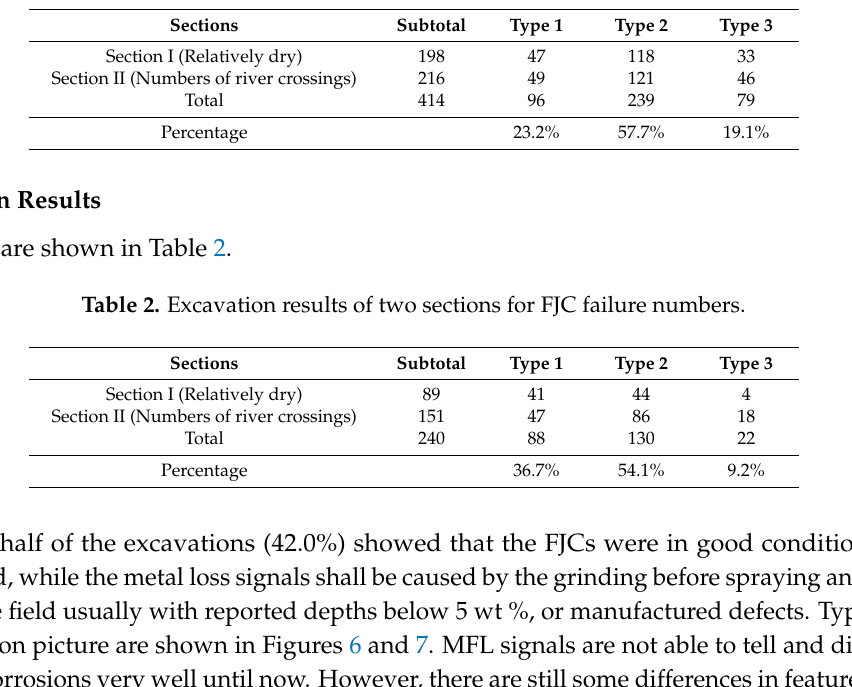
Table 1. Excavations of two sections with different types.